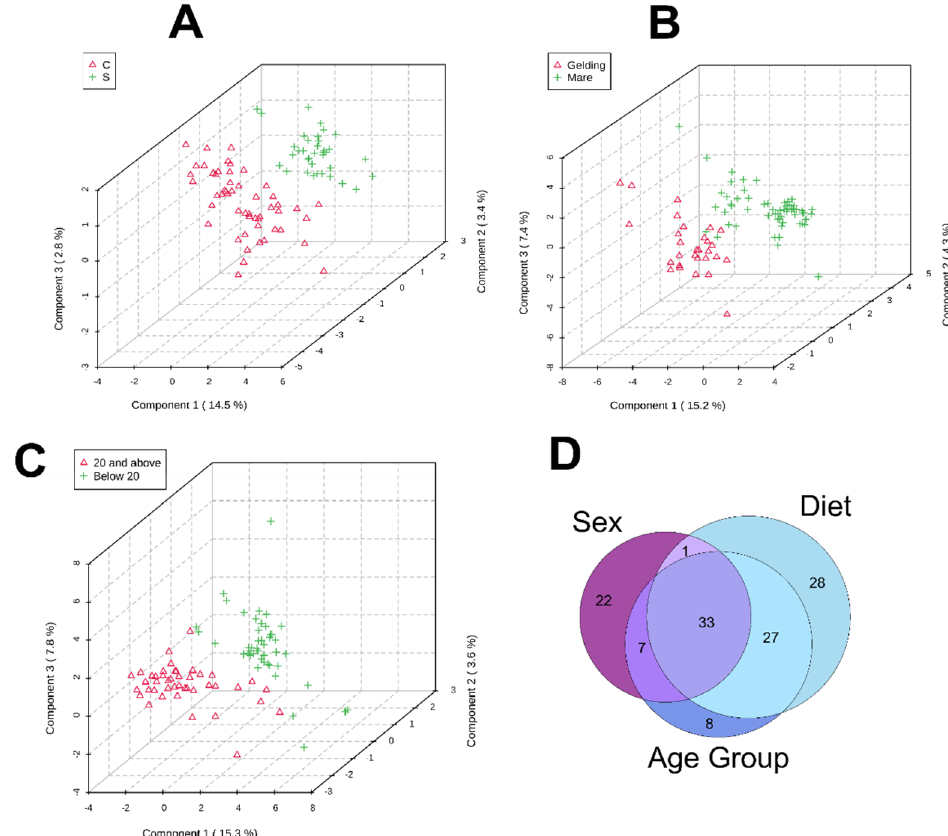
Figure 4. PLS-DAs of known metabolites and unidentified features detected in the metabolomes of all horses that were enrolled in the refeeding program grouped by ( A ) diet (C vs. S), ( B ) sex (mare vs. gelding), and ( C ) age group (below 20 and 20 and above). Sample sizes used for PLS-DAs were as follows C: n = 52; S: n = 36; mare: n = 59; gelding: n = 29; below 20: n = 45; 20 and above: n = 43. Venn Diagram ( D ) displaying similarities and differences between features in each grouping.